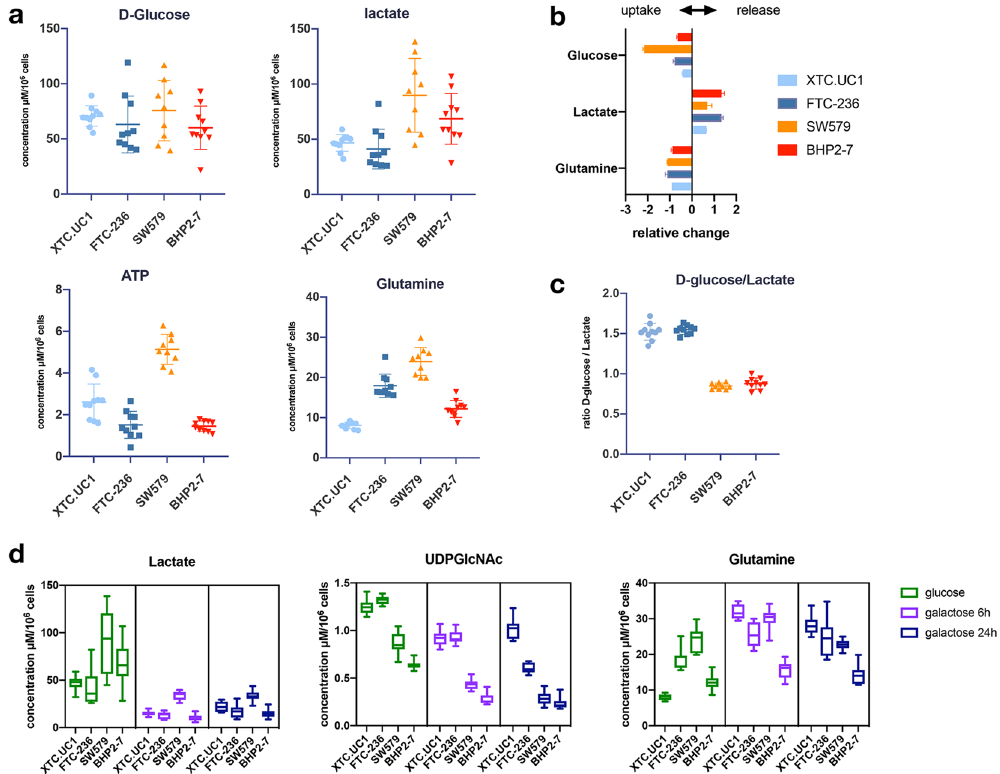
Figure 4. Uptake and metabolism of glucose and glutamine in XTC.UC1, FTC-236, SW579 and BHP2-7; ( a ). intracellular levels of D-glucose, lactate, glutamine and ATP; ( b ). uptake and release of D-glucose, lactate and glutamine (expressed as relative change, i.e. μ mol/h/10 6 cells of each metabolite in each cell line divided by the mean of the same metabolite); ( c ). ratios of intracellular D-glucose to intracellular lactate for each cell line; ( d ). intracellular levels of D-glucose, lactate and glutamine in normal culture medium and under glucose exchange by galactose for 6 and 24